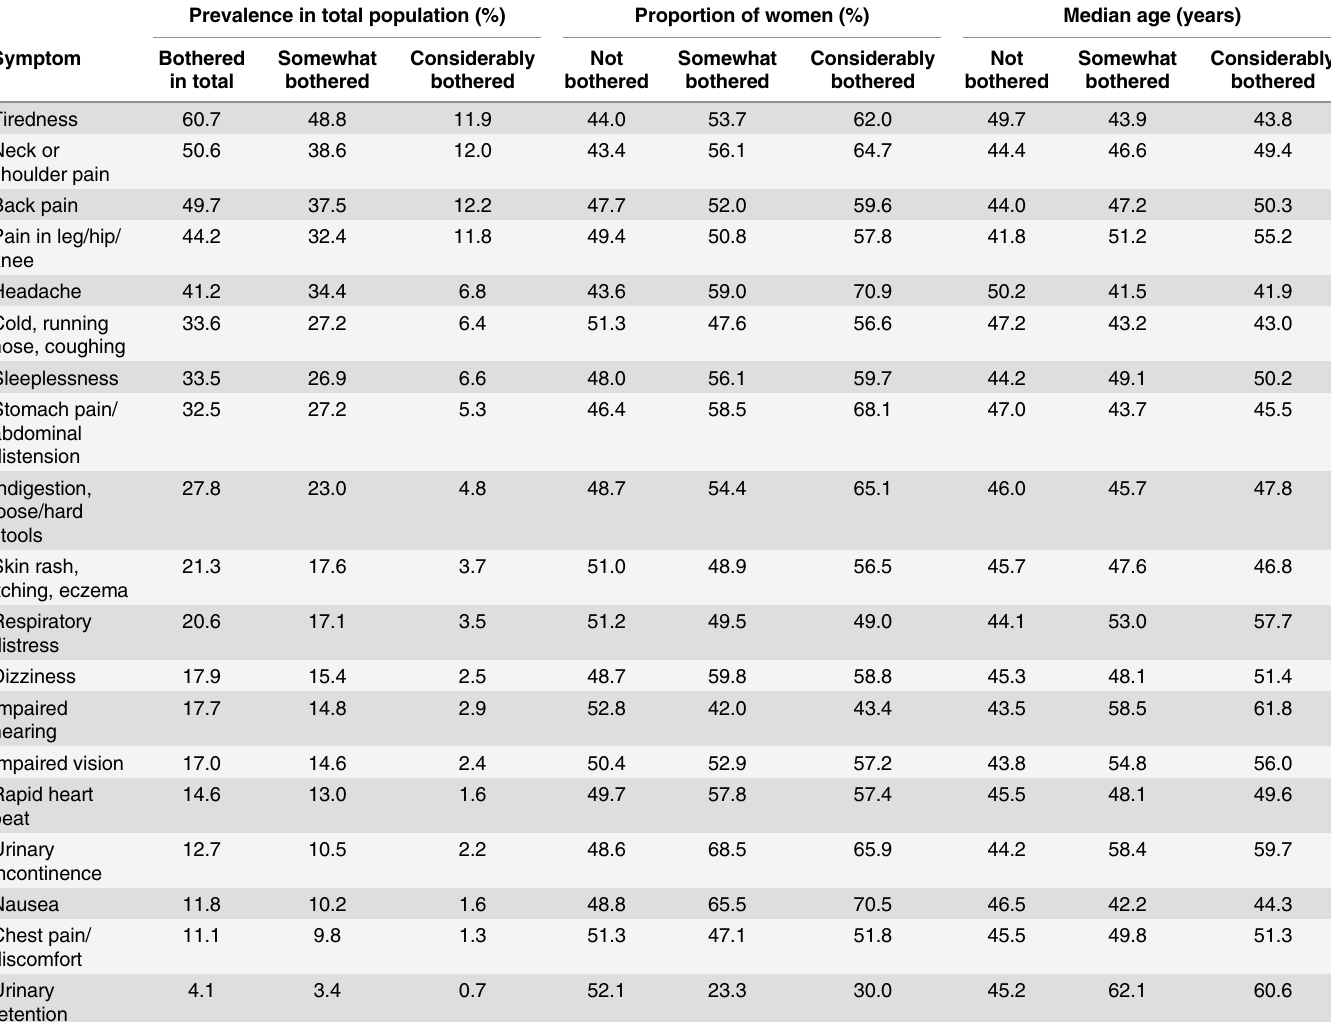
Table 1. The prevalence of 19 experienced somatic symptoms during 14 days including the proportion of women and the median age in the three symptom categories. The Regional Health Survey 2006/2007, the Capital Region of Denmark. N = 35,122 – 35,810. Prevalence in total population (%) Proportion of women (%) Median age